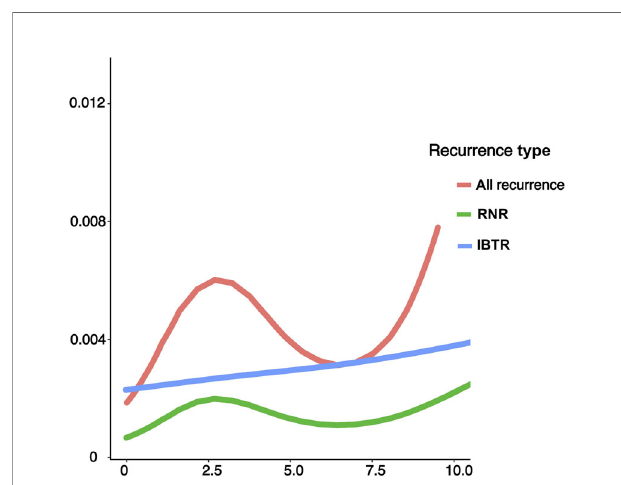
FIGURE 2 | Annual recurrence rates of loco-regional recurrence after lumpectomy in the entire population and categories of different types of recurrence. IBTR, ipsilateral breast tumor recurrence; RNR, regional nodal